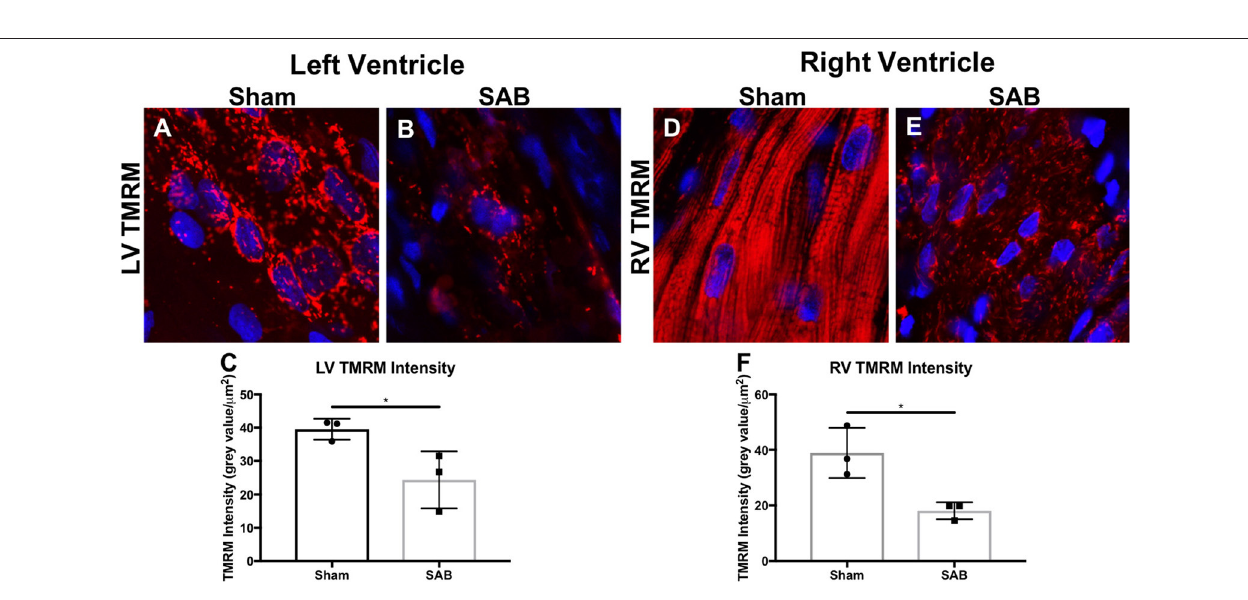
Frontiers in Cardiovascular Medicine | www.frontiersin.org